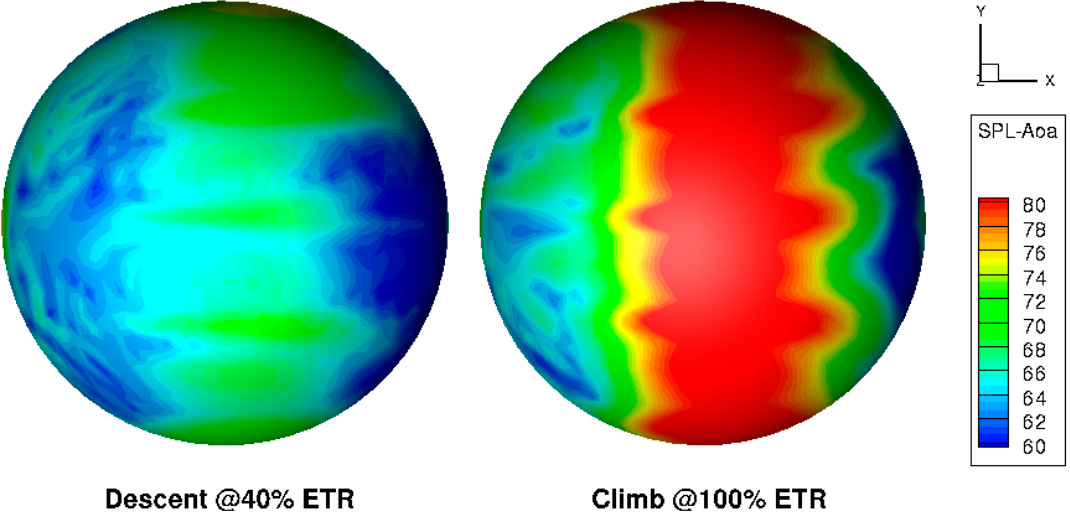
Figure 19. Configuration A, OASPL-A, in decibels, on the sphere, top view, in the two flight conditions analysed.